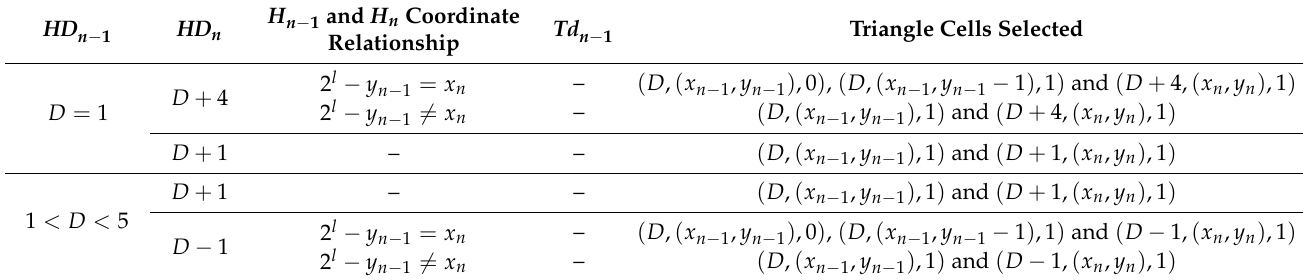
Table 11. Htotcode rule of the ( n − 1)th hexagon cell C 3